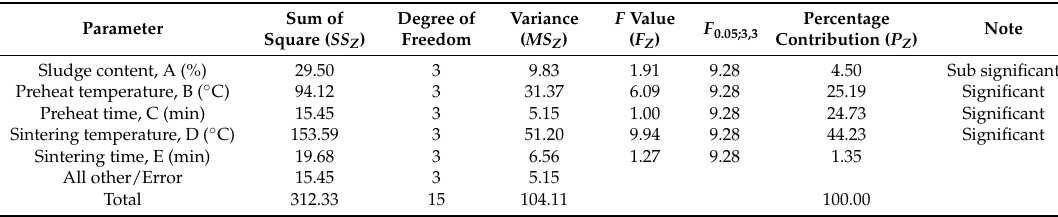
Table 11. Analysis of variance and F test for bloating ratio.